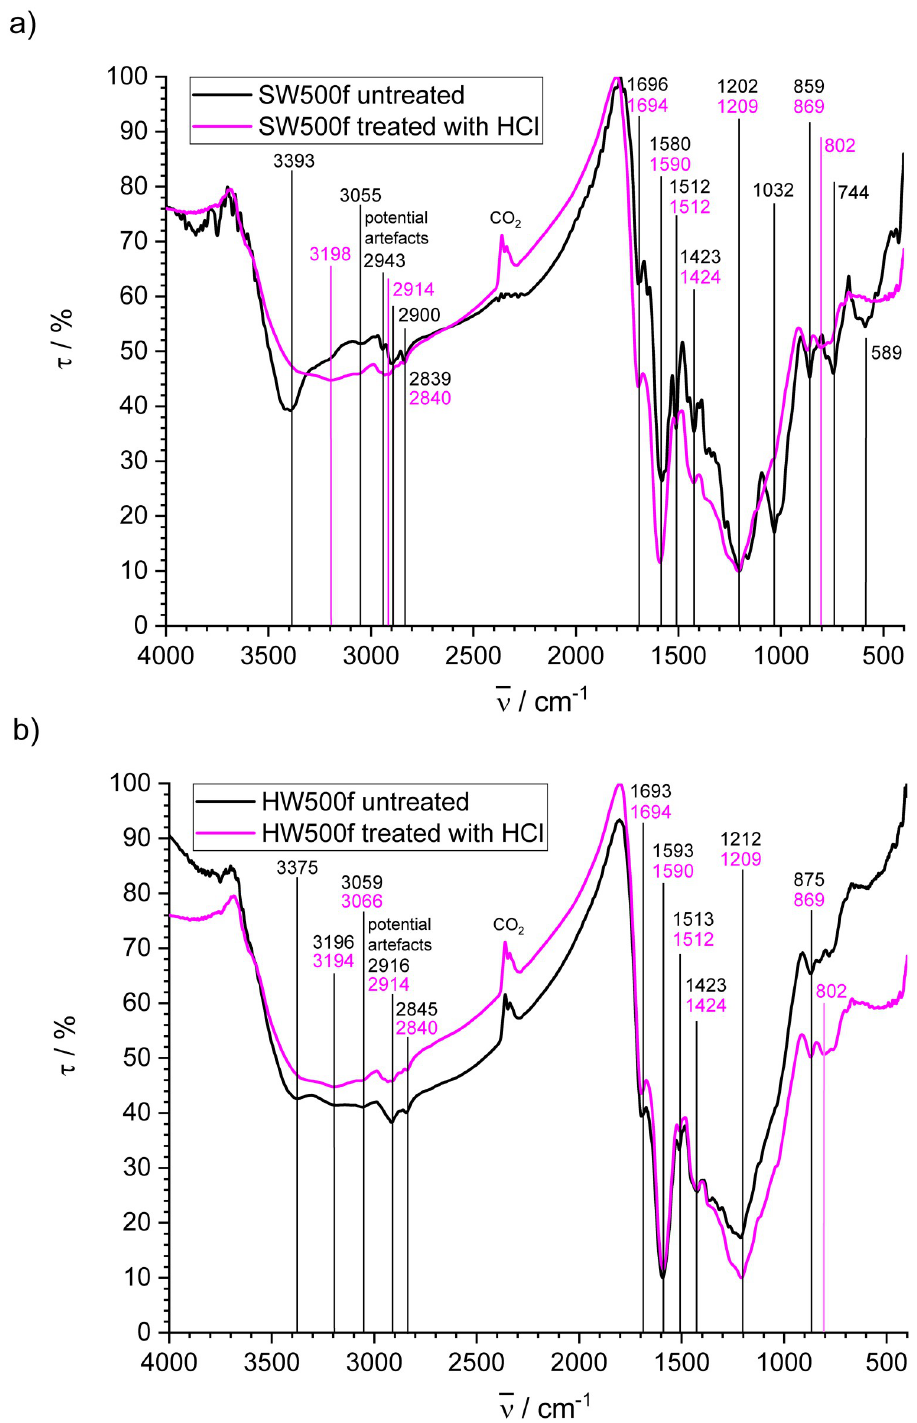
Fig 5. FT-IR spectra of biochars made by fast pyrolysis untreated and treated with HCl; a) SW500f; b) HW500f.